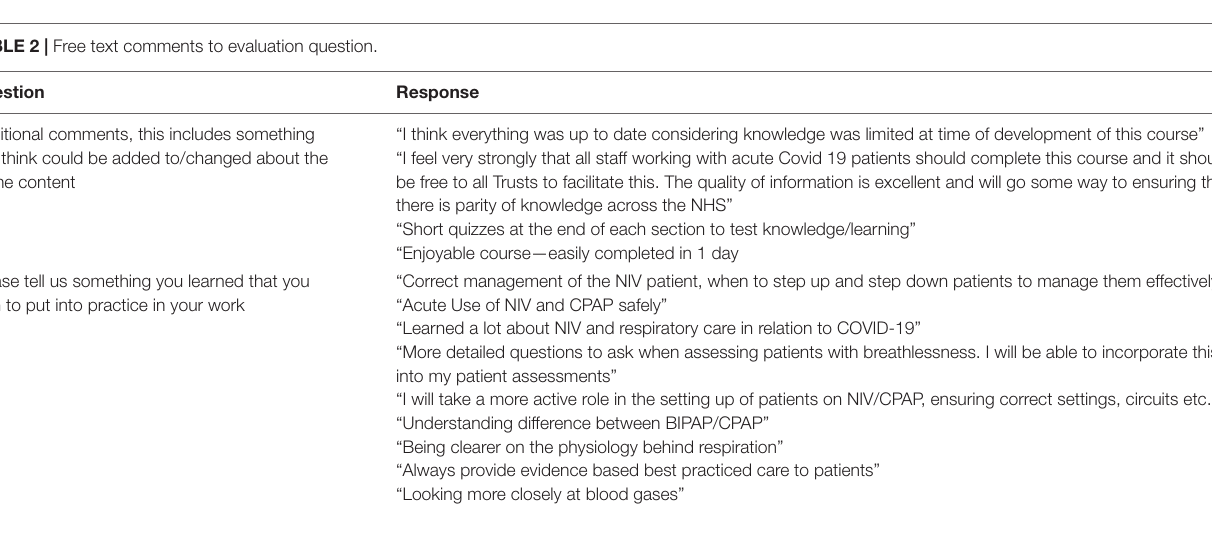
TABLE 2 | Free text comments to evaluation